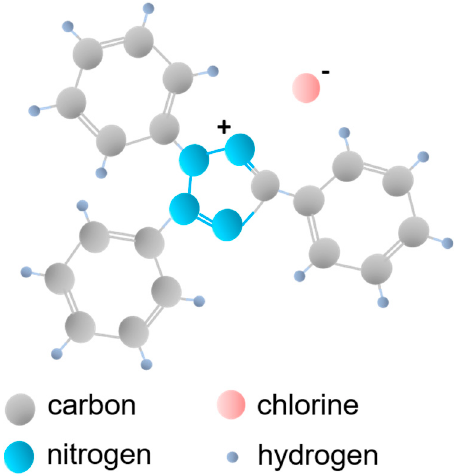
Figure 1. Structure of 2,3,5-triphenyltetrazolium chloride ionic liquid ([TPTZ][Cl]) used for the TPTZ_TiO 2 microparticles preparation.